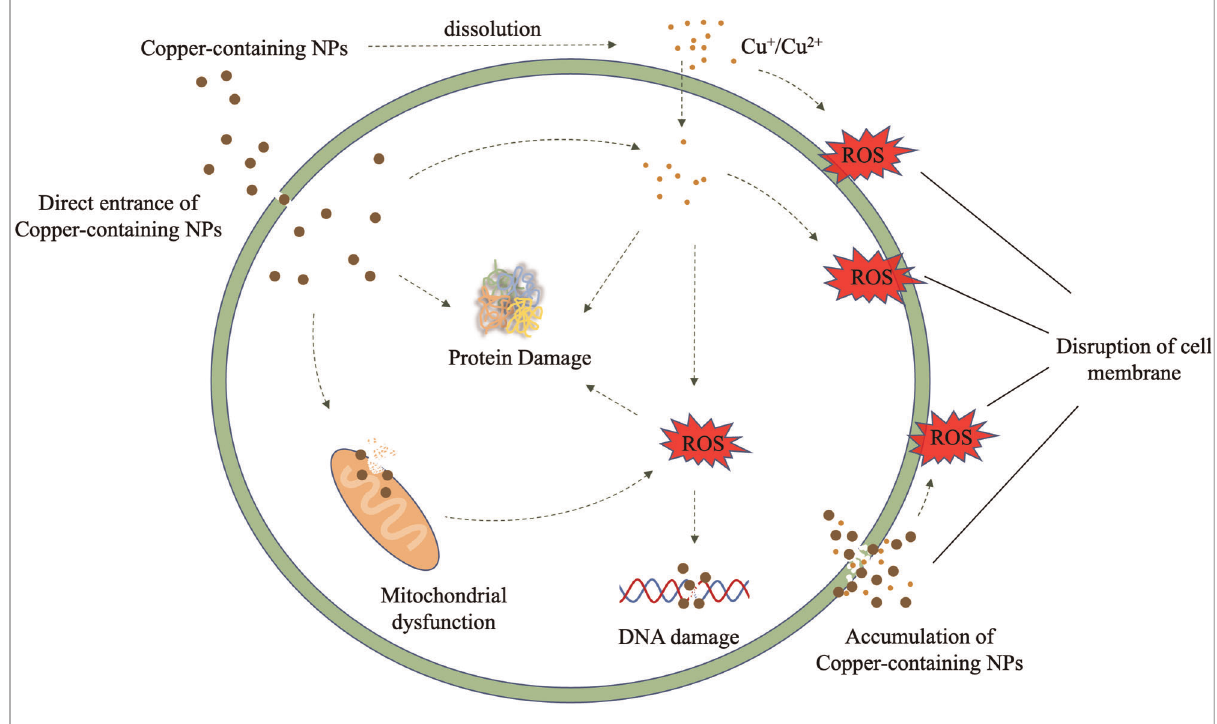
FIGURE 1 Illustration of possible antibacterial mechanism of Copper-containing